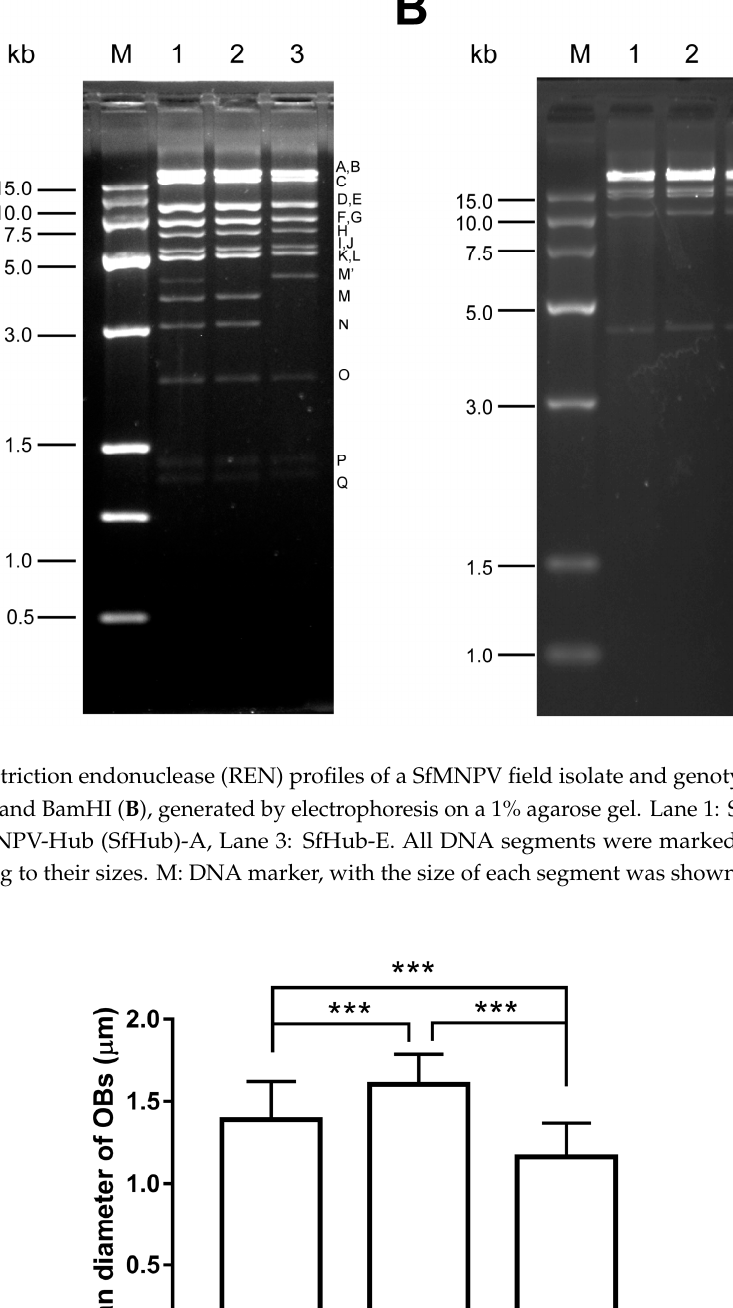
μ m), while SfHub ‐ E OBs (1.132 ± 0.206 μ m) were significantly smaller (Figure 3).